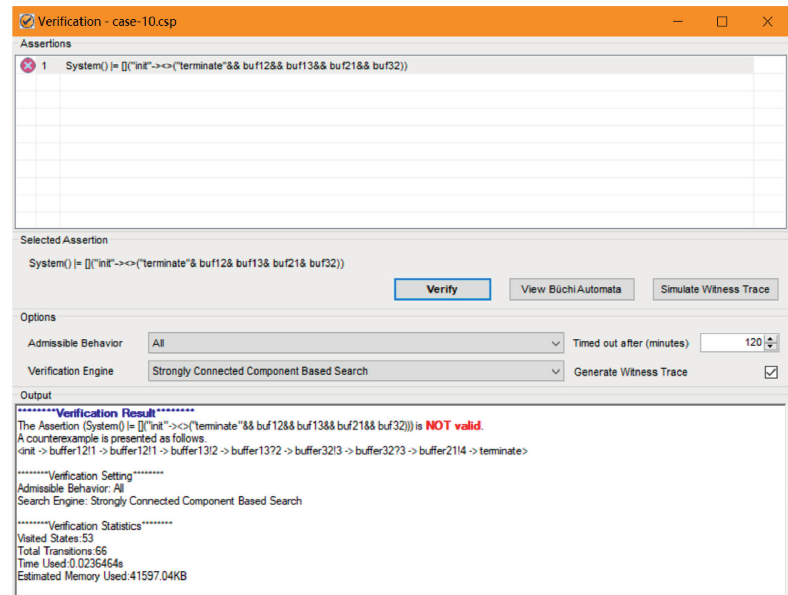
Figure 7: A snapshot of the verification result using the PAT Table 1: Verification results for all cases.